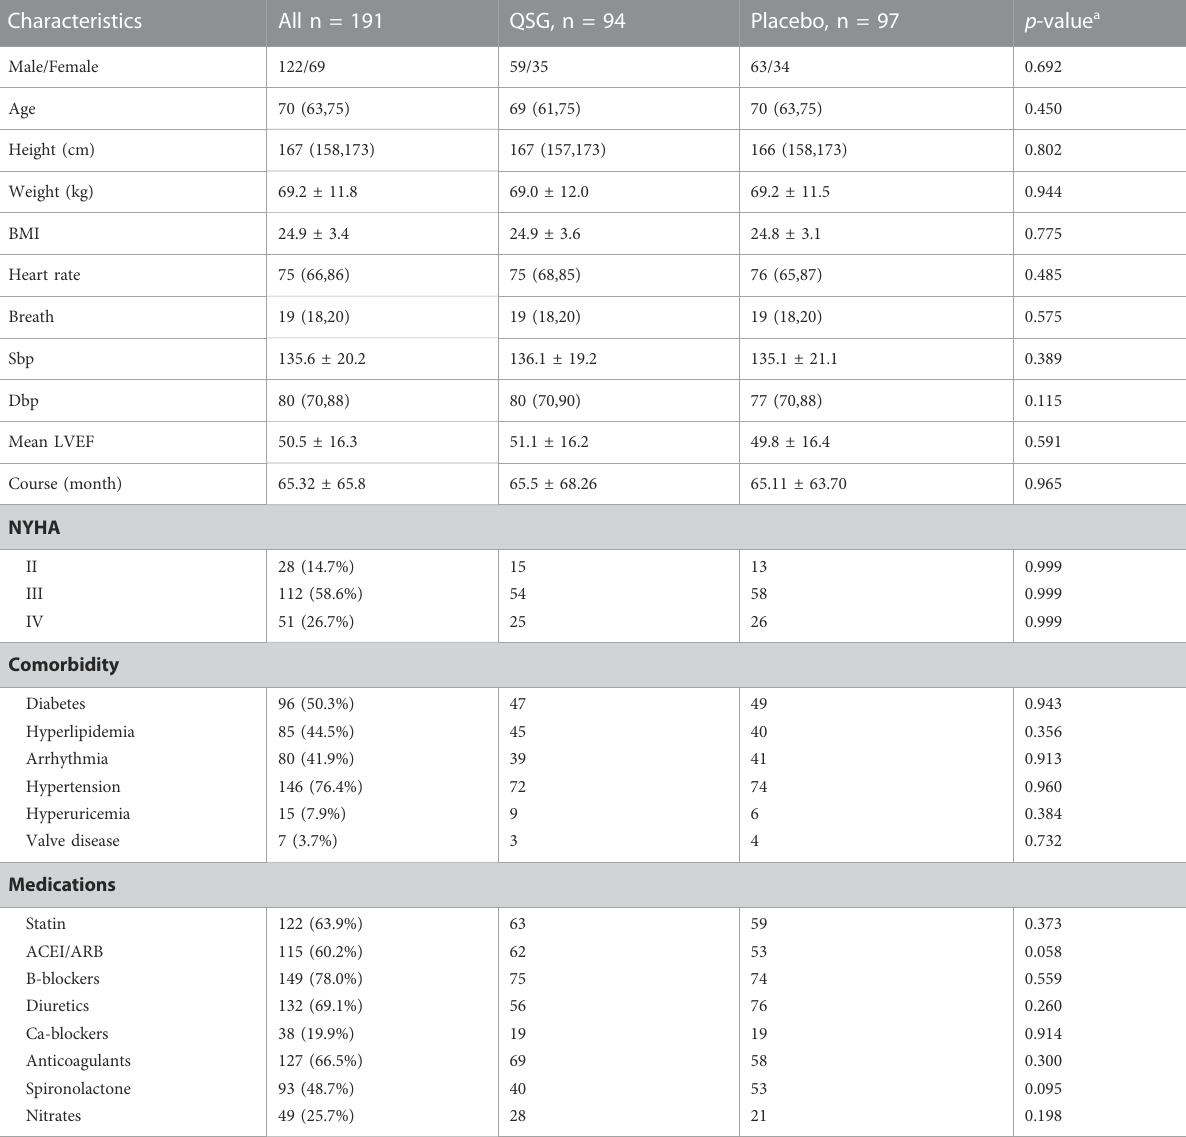
TABLE 1 Baseline characteristics of